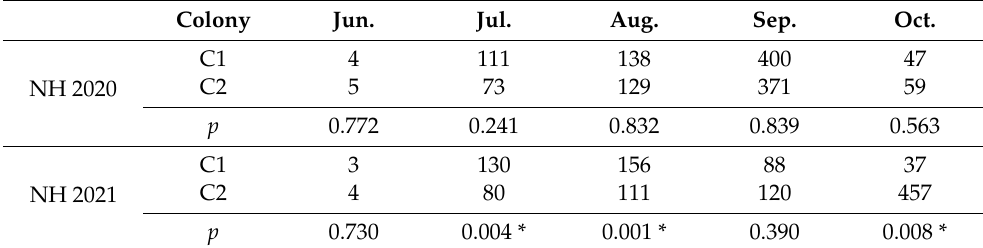
Table 1. Observations of hornets in front of each beehive per month and in each year. Colony Jun. Jul. Aug.